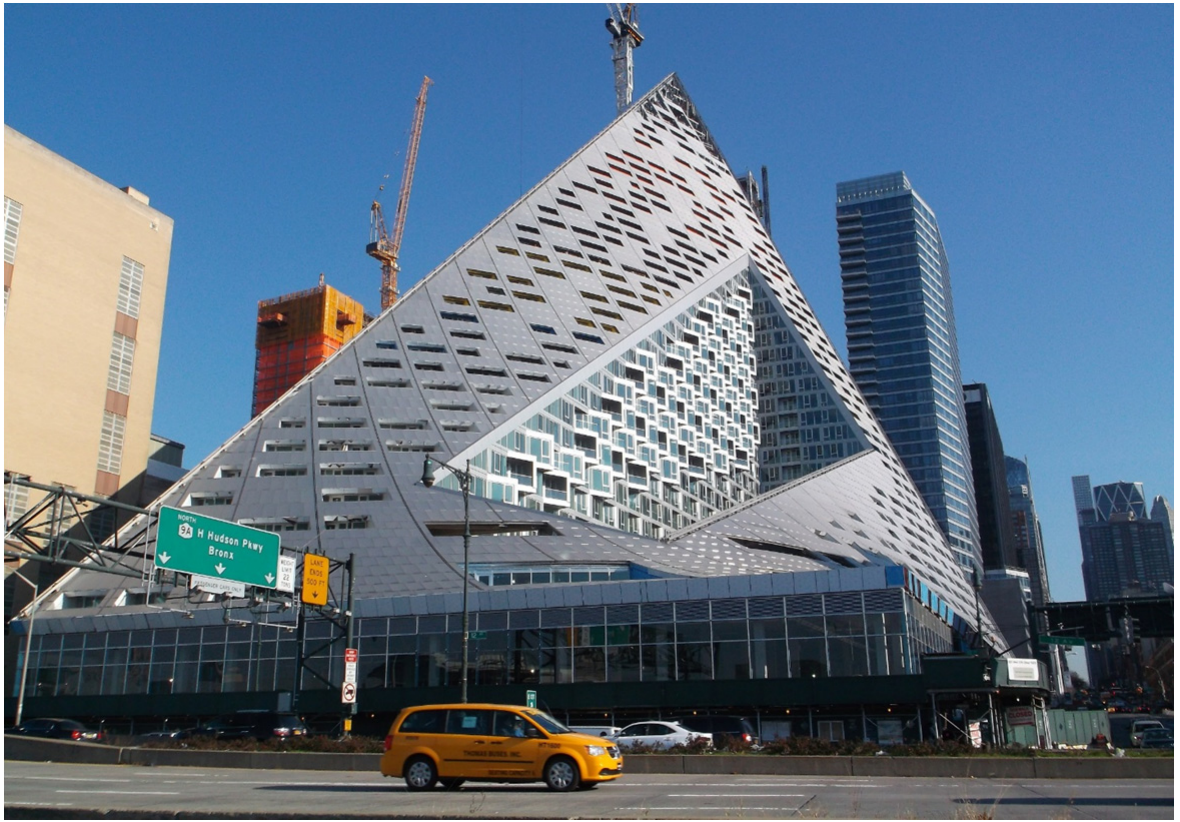
Fig. 2 Sloped Façade Construction as of November 2015.